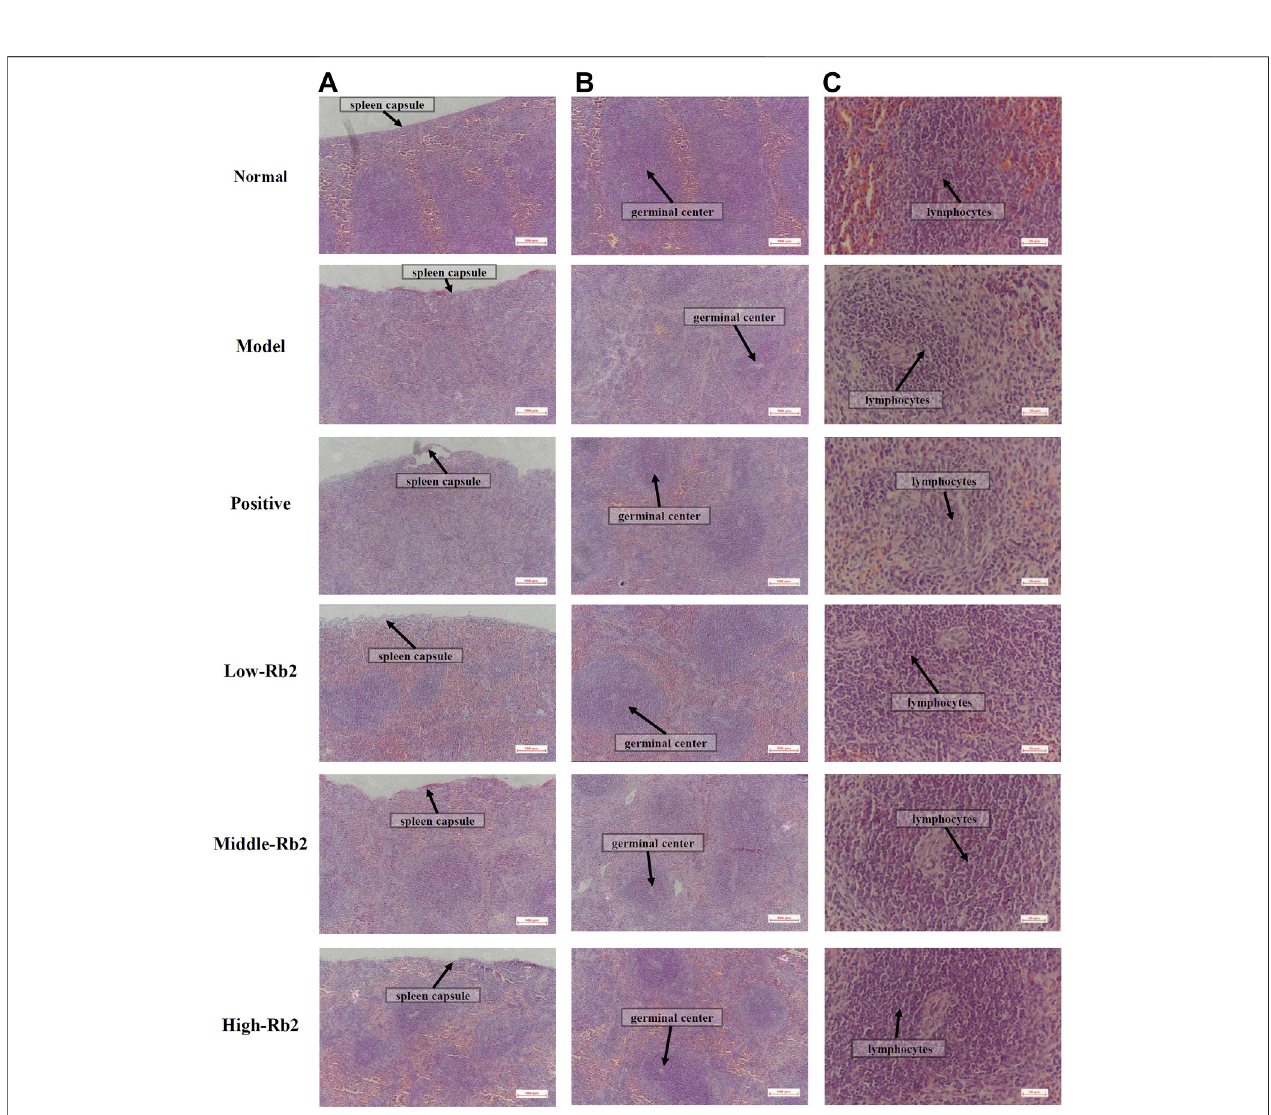
FIGURE 1 | Histopathology observation of spleen. (A) ×100, (B) ×100, (C) ×400.